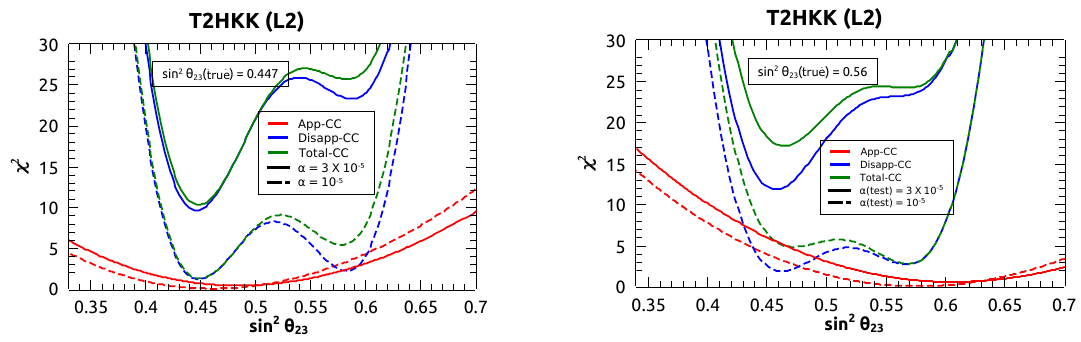
Figure 7 . The χ 2 as a function of θ 23 . The left (right) panels are for true sin 2 θ 23 = 0 . 447 ( sin 2 θ 23 = 0 . 56 ) respectively. The red and blue curve are for appearance and disappearance chan- nels respectively. While the total contribution from both the channels is represented by green curves. The solid curves are for α (test) = 3 × 10 − 5 eV 2 and the dashed curves for α (test) = 10 − 5 eV 2 in the fit. The data have been generated for α = 0